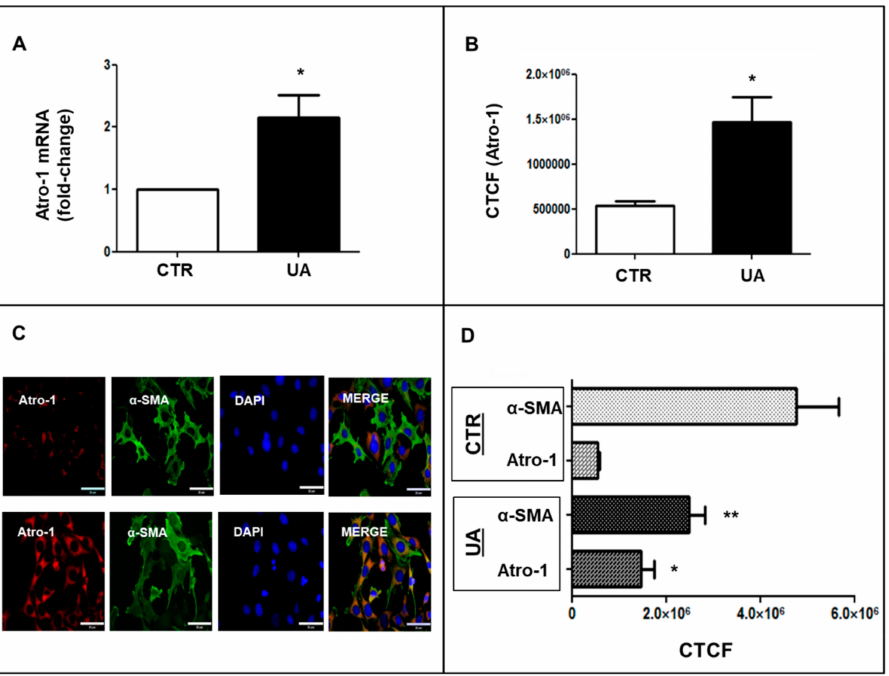
Figure 6. Atrogin-1 (red) and α SMA (green) after 48 h of treatment with UA 9 mg/dL. ( A ) UA treat- ment upregulated Atrogin-1 mRNA and ( B ) protein expression evaluated by immunofluorescence and reported as CTCF. mRNA was detected by rt-PCR. ( C ) UA-induced changes in expression and dis- tribution of Atrogin-1 (red) and α -SMA (green). ( D ) Signal intensities were evaluated by Image J and expressed as CTCF. * p < 0.05 and ** p < 0.01 vs. CTR. rt-PCR results represent means ± SEM obtained from three/four independent experiments and are expressed as fold change to CTR. For CTCF, at least 100 cells for condition from three independent experiments were evaluated. Magnification = × 400, scale bar = 35 µ m. Atro-1 = Atrogin-1; α -SMA = α -Smooth Muscle Actin; VSMC = Vascular Smooth Muscle cells; UA = Uric Acid; rt-PCR = real time PCR; CTR = control untreated cells; CTCF = Corrected Total Cell Fluorescence; DAPI = 4 (cid:48) ,6-diamidino-2-phenylindole